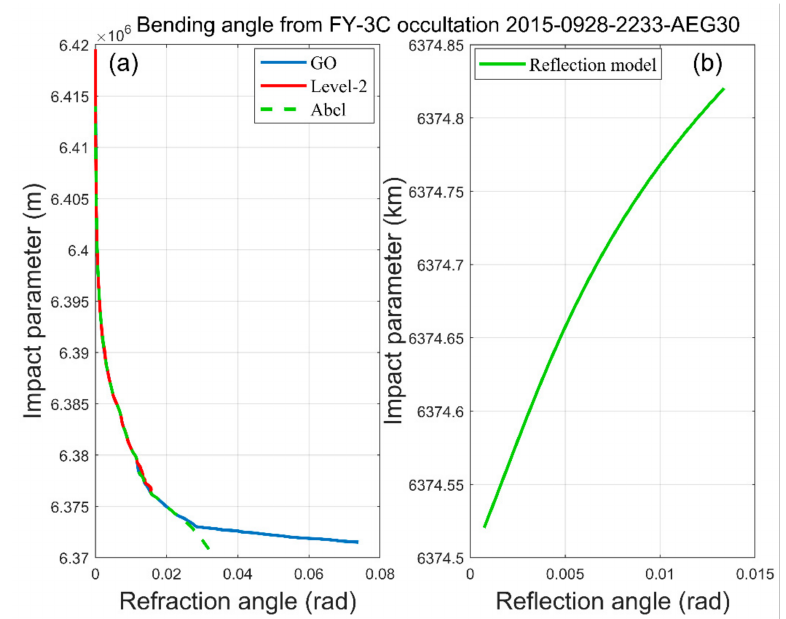
Figure 9. Bending angles of FY-3C event on 28 September 2015: in ( a ), the red curve shows the bending angles of refractivity profile from cutting height to 40 km altitude, the green dashed curve shows the bending angles by Equation (6) and the blue curve shows the recalculated bending angle by GO method from Earth’s surface to 40 km altitude. ( b ) shows the reflected bending angle model extracted by Equation